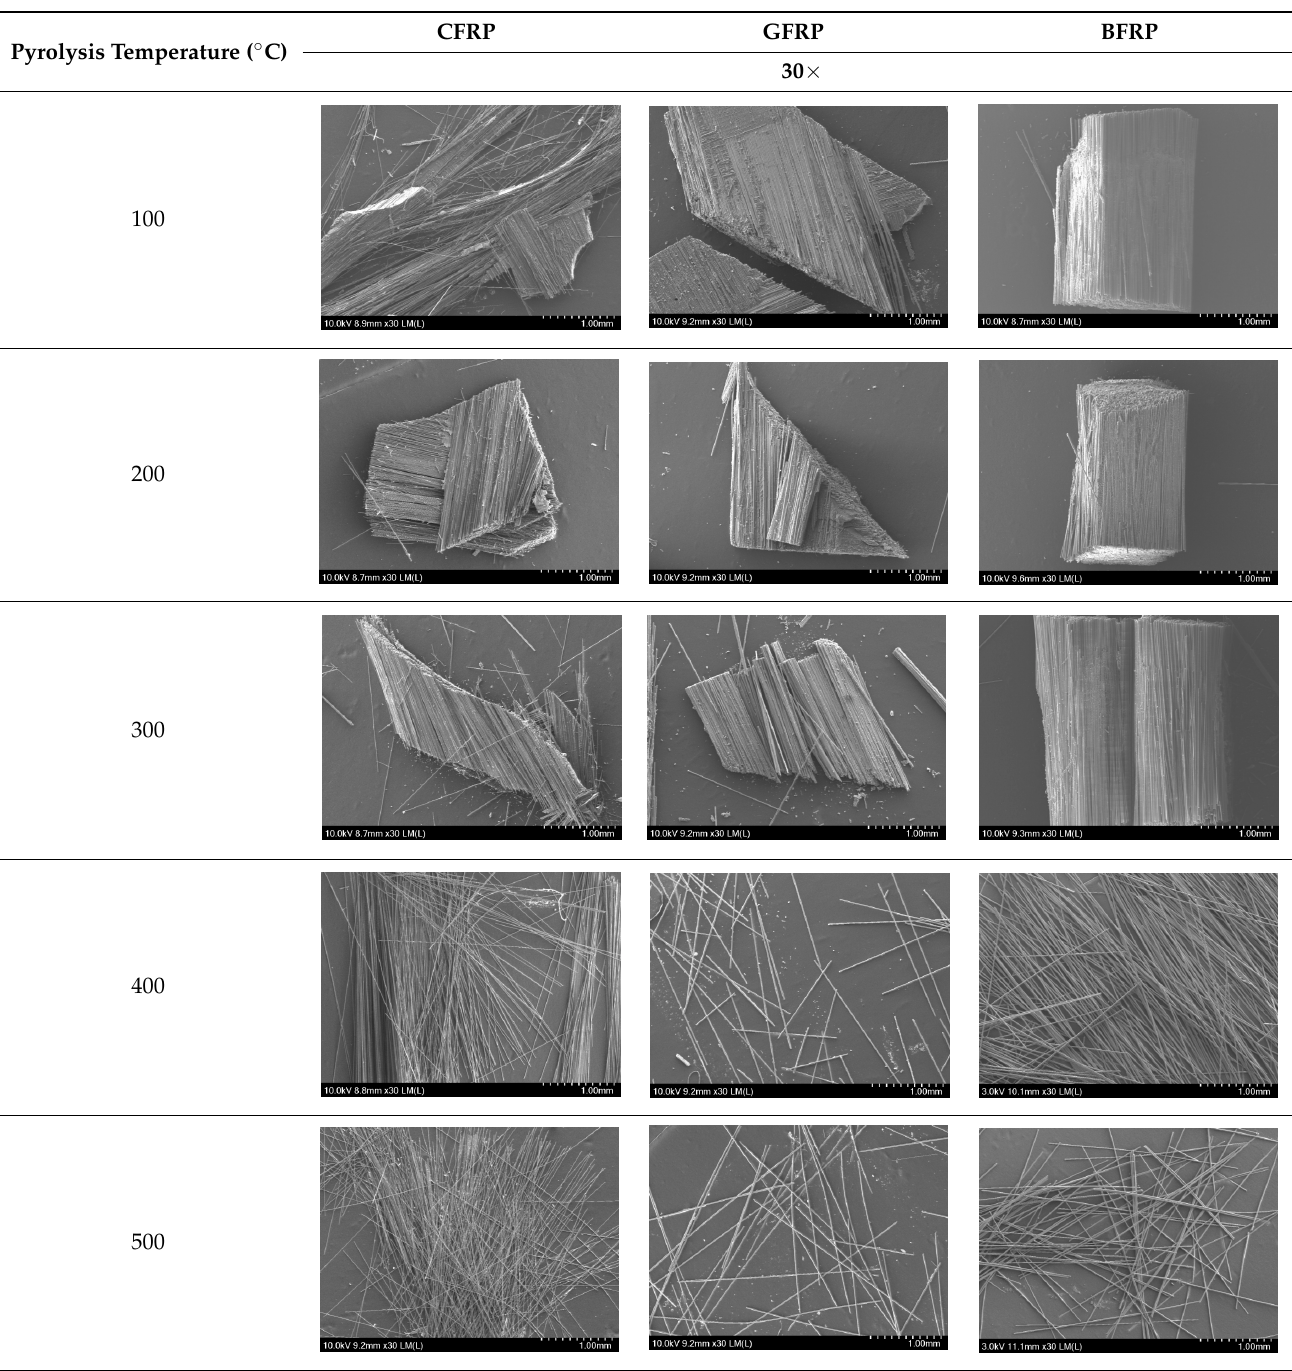
Table 3. Surface morphology of CFRP, GFRP, and BFRP according to pyrolysis temperature (30×).